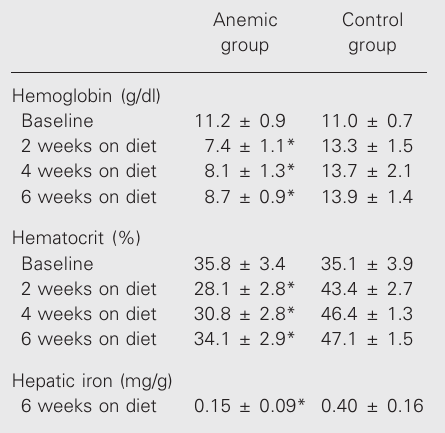
Table 1. Hemoglobin, hematocrit and hepatic iron in rats with iron-deficiency